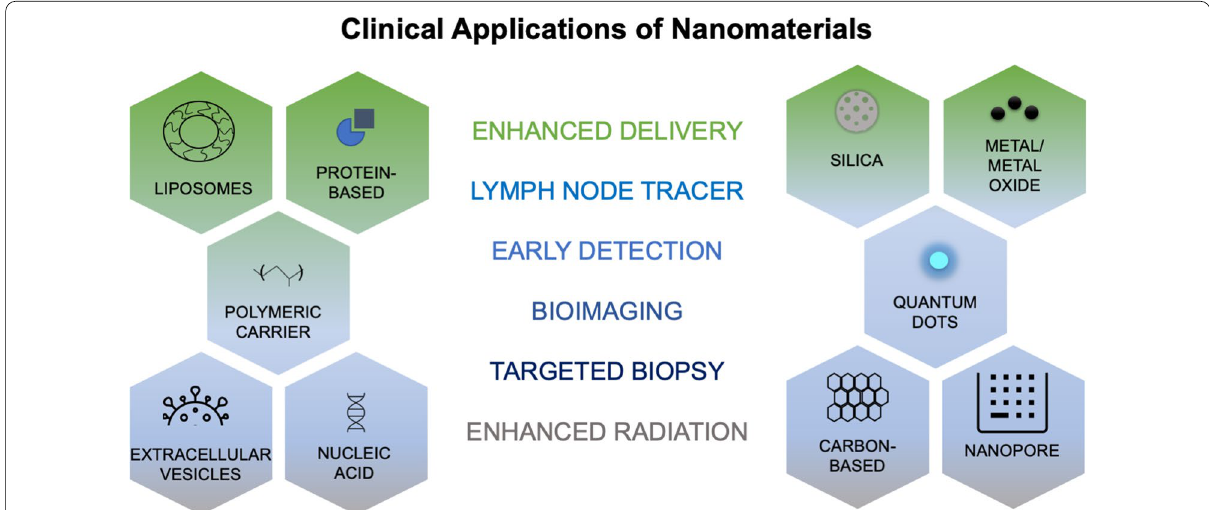
Fig. 2 Examples of nanomaterials currently being investigated in clinical trials for various applications to improve therapeutic delivery, diagnostics, radiation therapy, and imaging